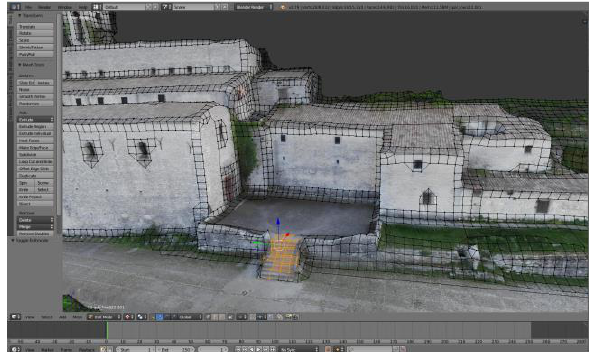
Figure 8. Google Earth before and after the publication of the 3D